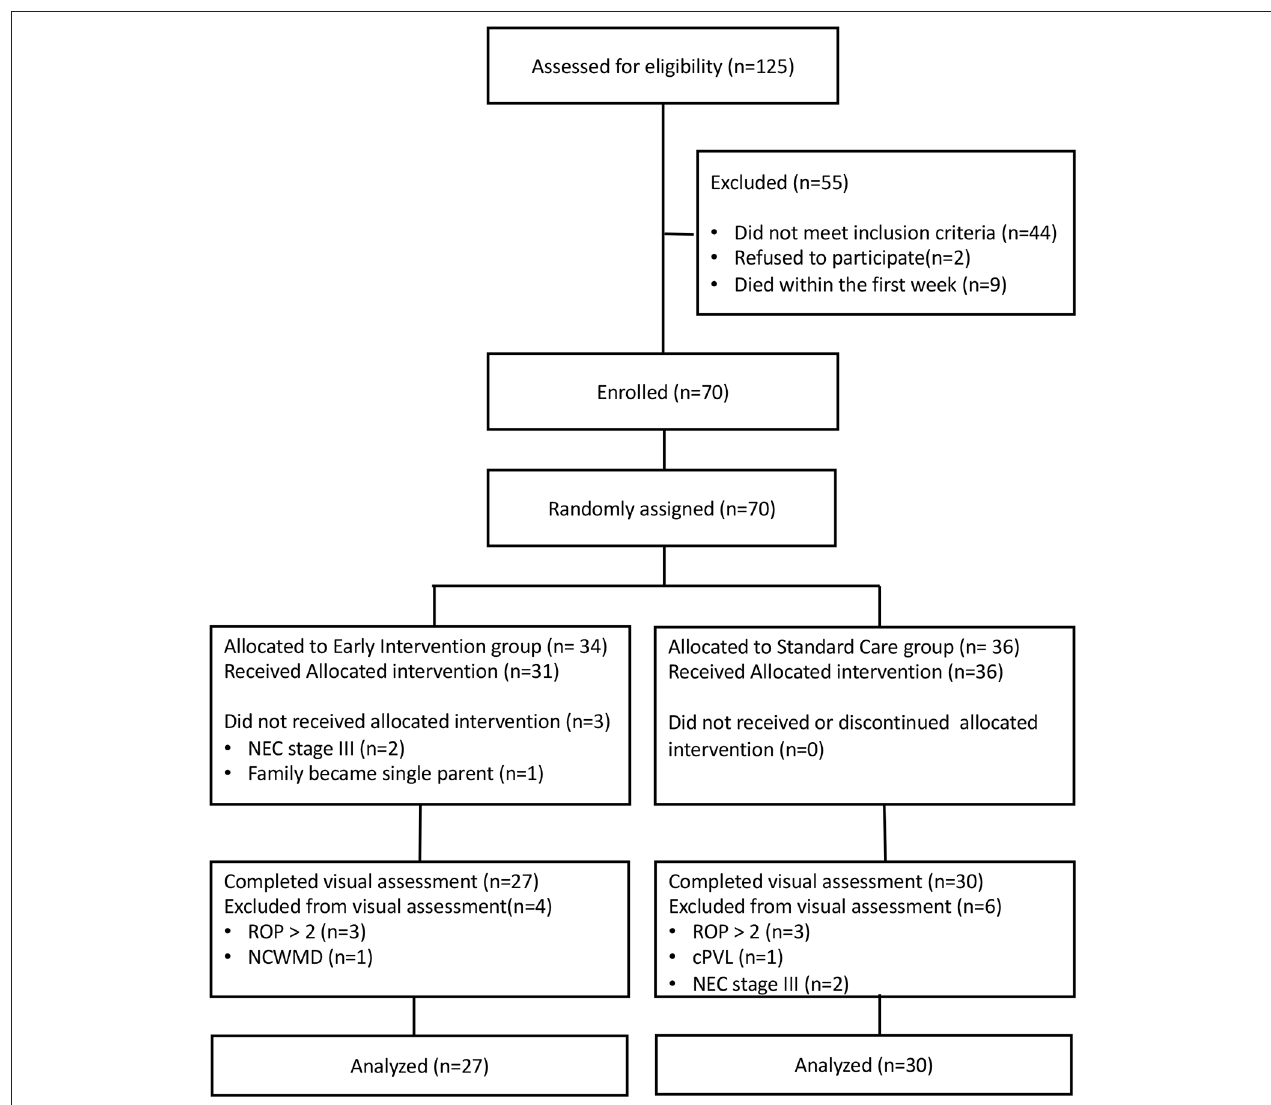
FIGURE 1 | Flow chart of the